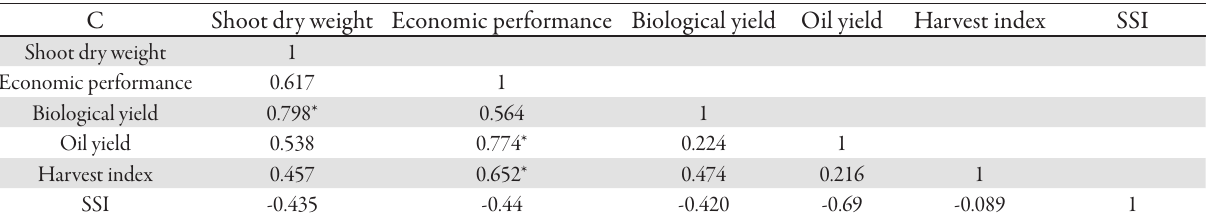
Tab. 6. Correlation between dry matter, economic performance, biological yield, oil yield, harvest index and stress susceptibility index (SSI) characteristics in the control condition (normal condition, C)